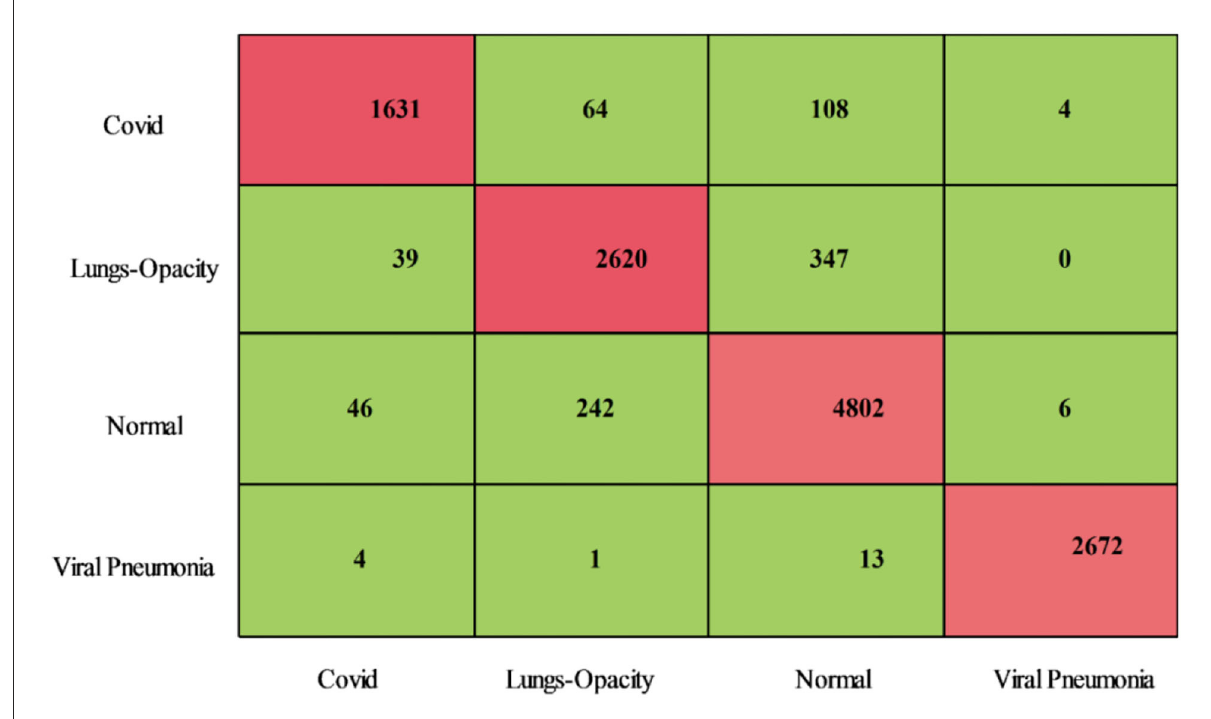
FIGURE8 Confusion matrix of CSVM using proposed optimization method on COVID-19 Radiography